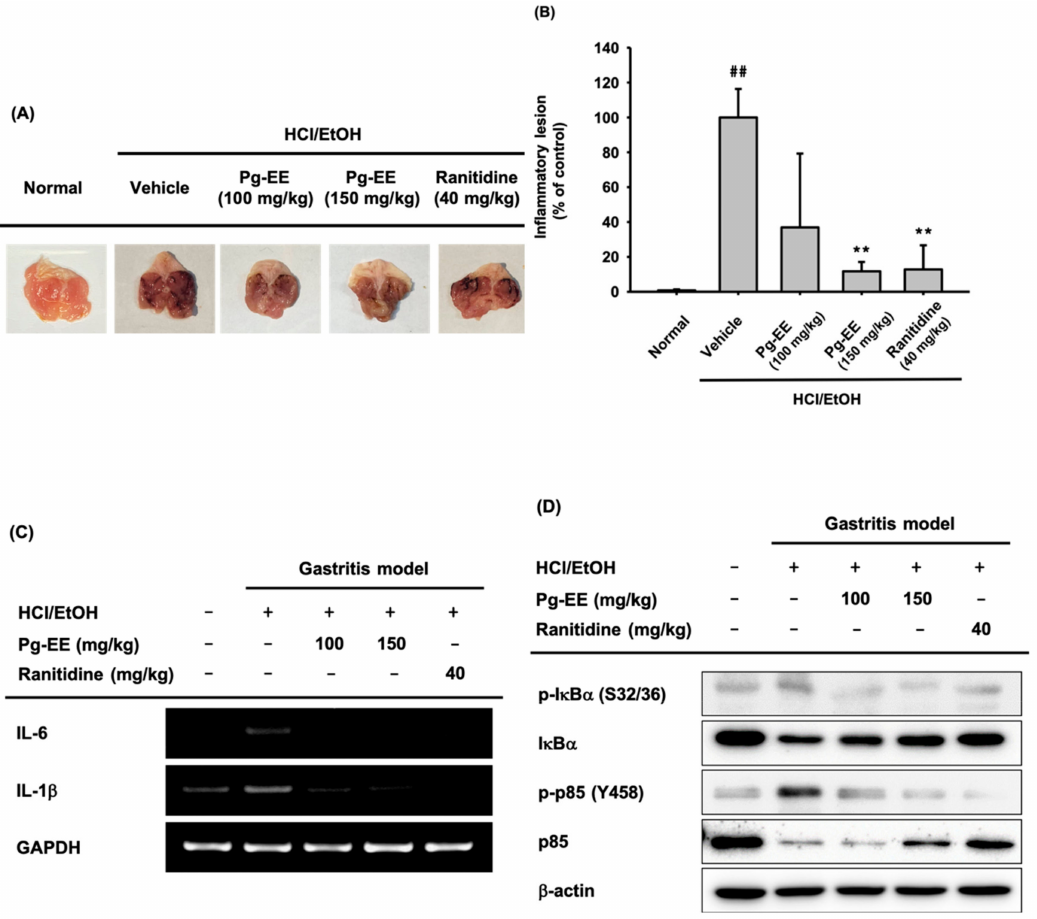
Figure 5. E ff ect of Pg-EE on the inflammatory symptoms in an HCl / EtOH-induced gastritis model. ( A ) Pg-EE (100 or 150 mg / kg) or ranitidine (40 mg / kg) was orally injected into mice three times a day for two days, and gastritis was induced by HCl / 60% EtOH for 1 h before mice were sacrificed. ( B ) Stomach inflammatory lesions were photographed and quantified through ImageJ. ( C ) The mRNA expression levels of IL-6, IL-1 β , and GAPDH in the gastritis model treated with Pg-EE (100 mg / kg or 150 mg / kg) or ranitidine (40 mg / kg) were determined using semi-quantitative RT-PCR. ( D ) The protein levels of total and phospho-I κ B α (Ser32 / 36) and -p85 (Tyr458) were detected by an immunoblotting assay. ##: p < 0.05 compared to the normal group, *: p < 0.05 and **: p < 0.01 compared to the control group. − : no treatment and + :